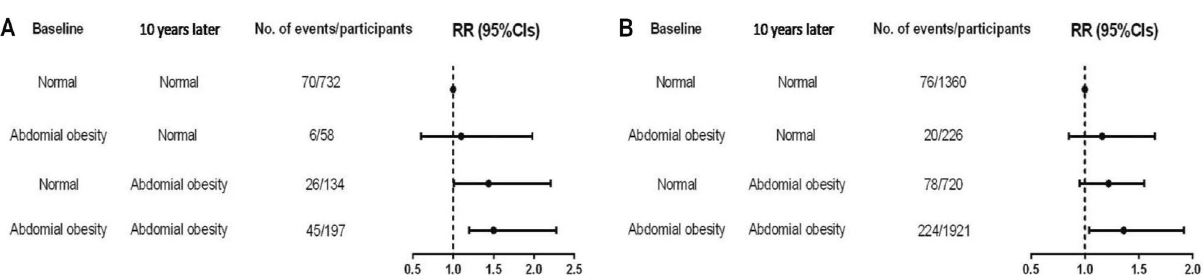
Figure 1. Risk of chronic obstructive pulmonary disease (COPD) by abdominal obesity among male ( A ) and female ( B ) participants at baseline and follow-up.